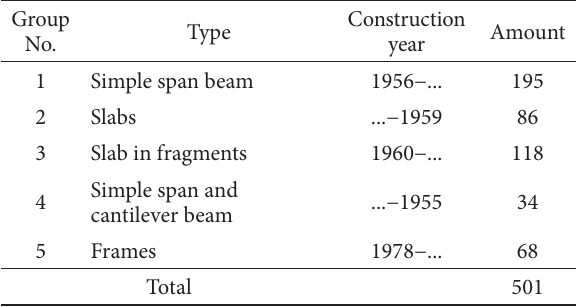
Table 2. Main typologies of Estonian national road bridges without interventions Group No.